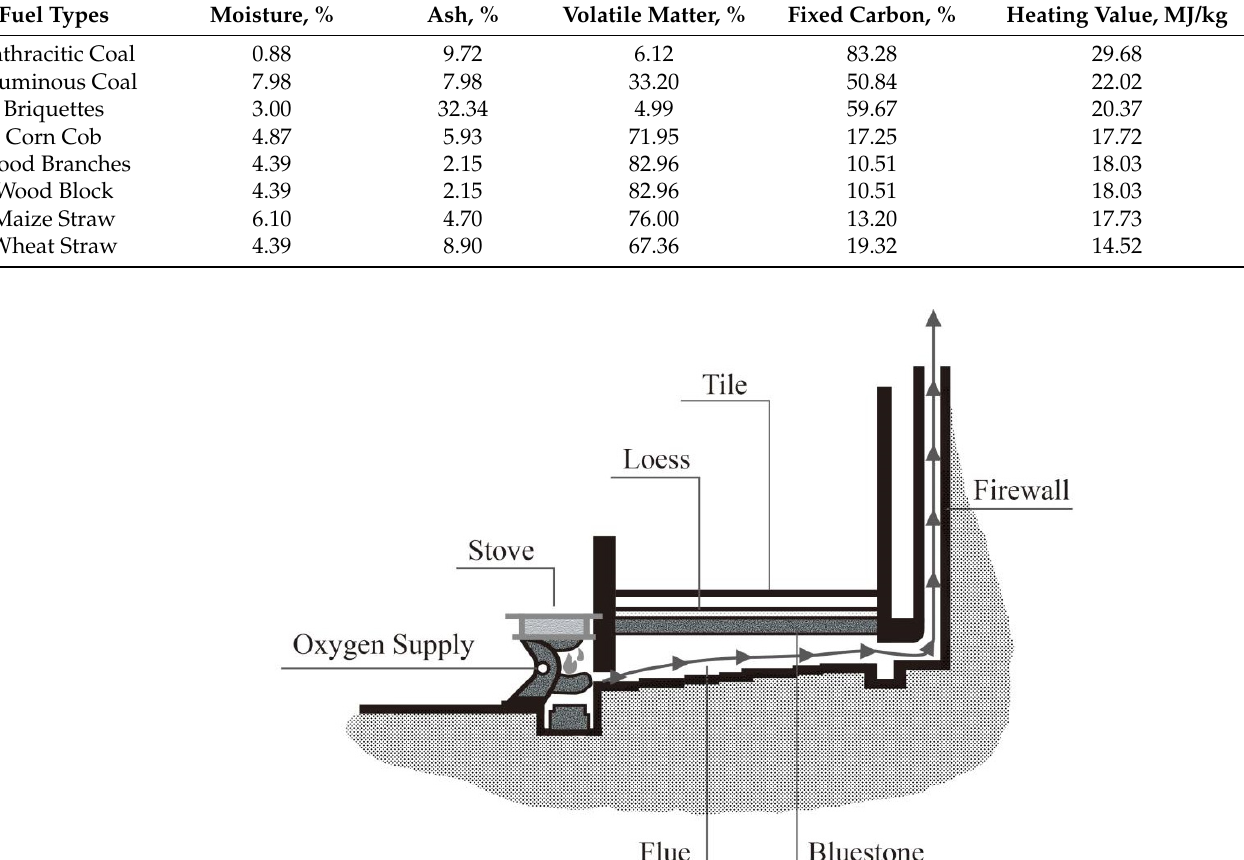
Figure 1. Schematic diagram of the structure of Heated Kang.